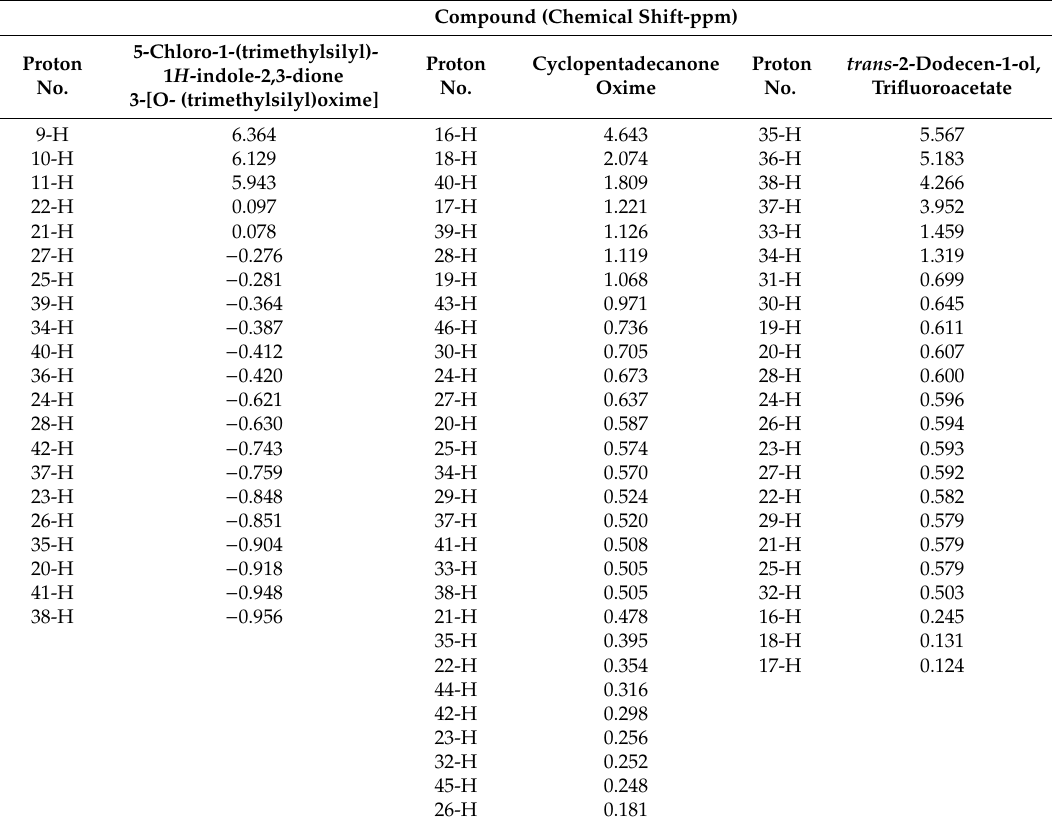
Table 5. Calculated 1 H-NMR isotropic chemical shift (TMS and chloroform solution) by the DFT / B3LYP / 6-31G + (d,p) method (atom positions are numbered in the table). Compound (Chemical Shift-ppm) Proton